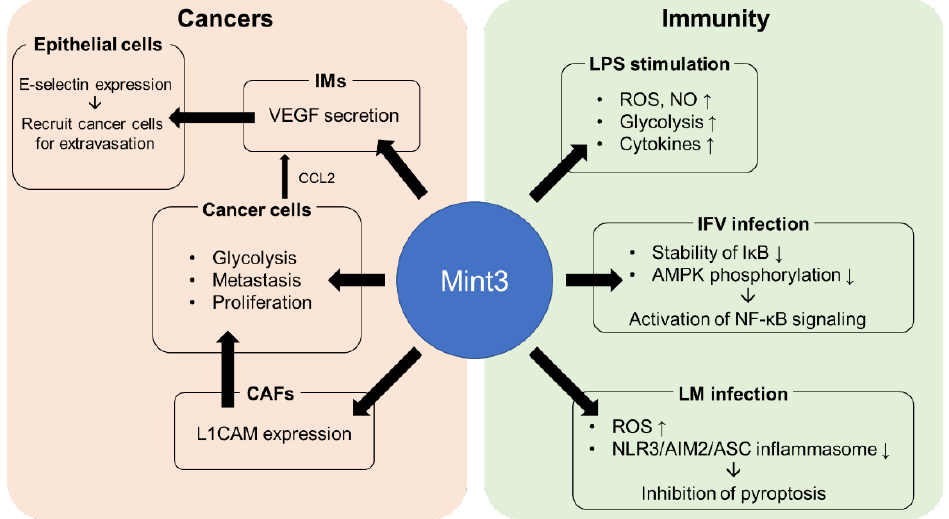
Figure 3. Summary of diverse effects of Mint3 on innate immune system and cancer progression . Mint3 mediates the production of cytokines/chemokines in various mechanisms depending on pathogens. In cancers, Mint3 promotes proliferation and metastasis with the involvement of inflammatory cells (IMs), cancer -associated fibroblasts (CAFs), or direct expression in cancer cells.